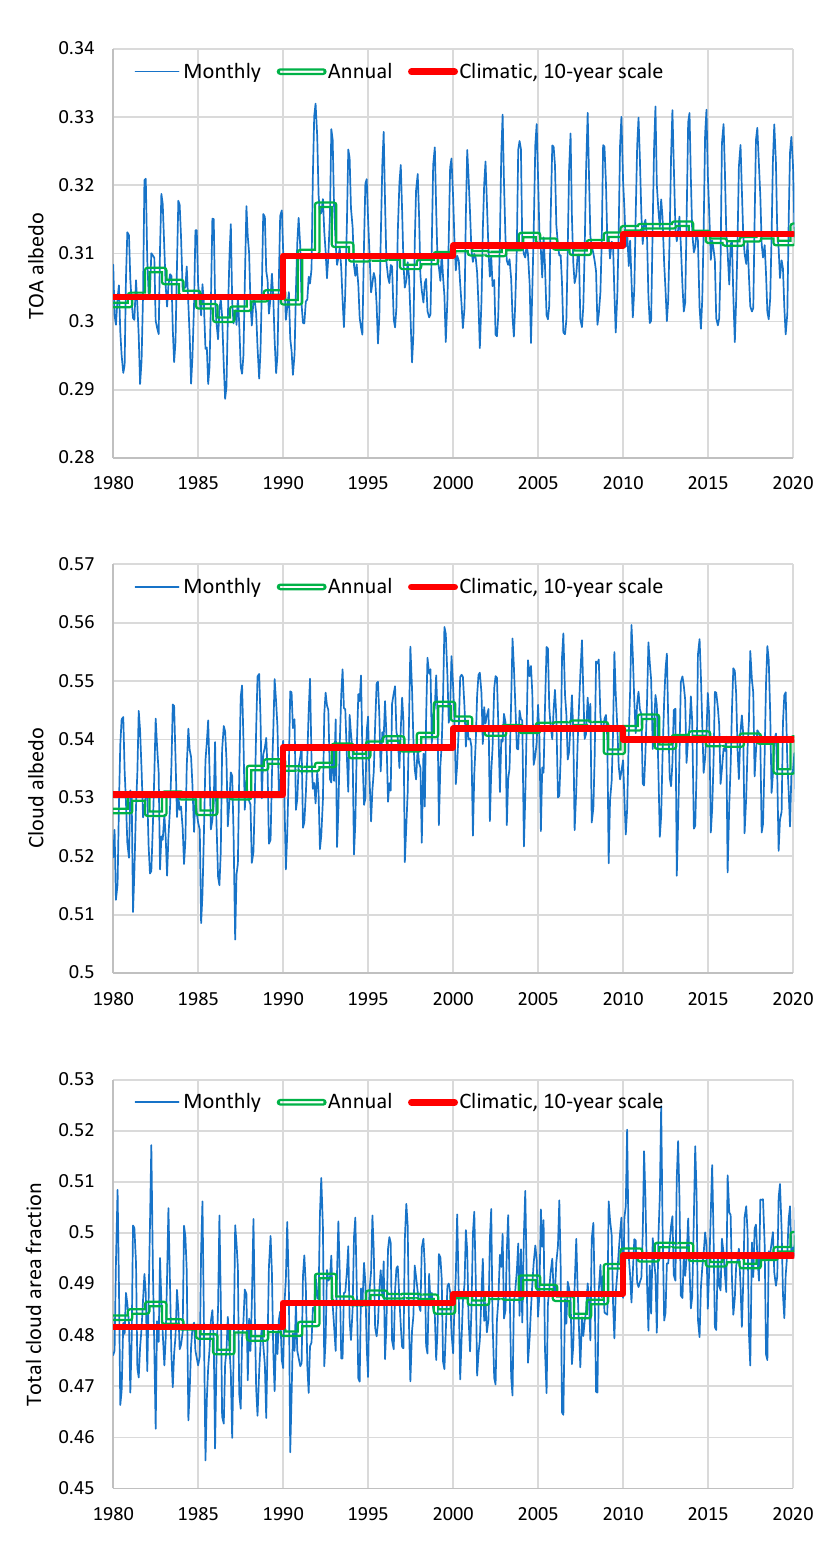
Figure A4. Time series of ( upper ) TOA albedo, ( middle ) cloud albedo and ( lower ) total cloud area fraction, as provided by NASA’s MERRA-2 International Satellite Cloud Climatology Project (ISCCP).